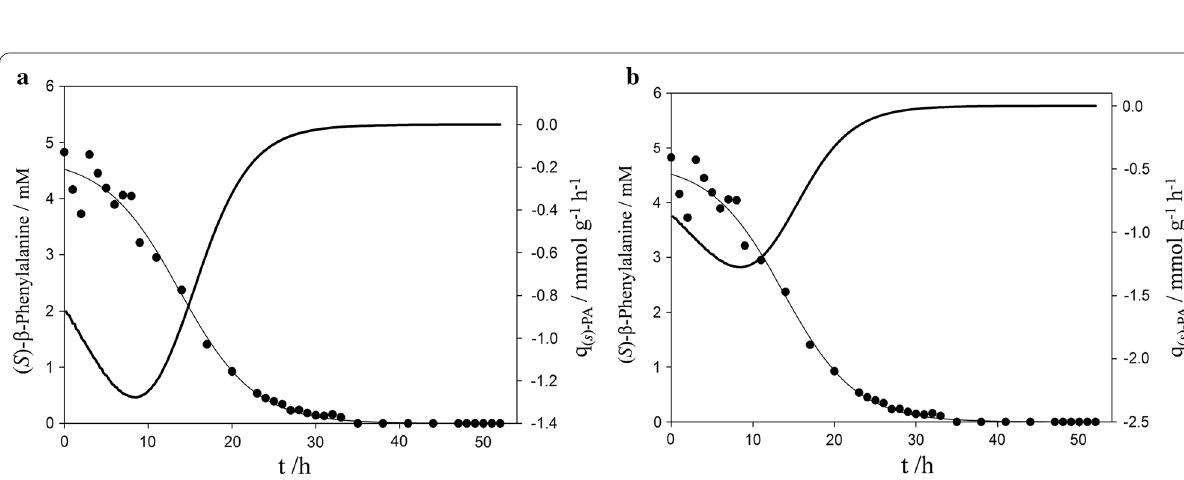
Fig. 3 Consumption rate of ( S) ‑β‑PA. Bold line—q ( s )‑PA . Points with line‑concentration of ( S) ‑β‑PA in bioreactor. a BS115, b